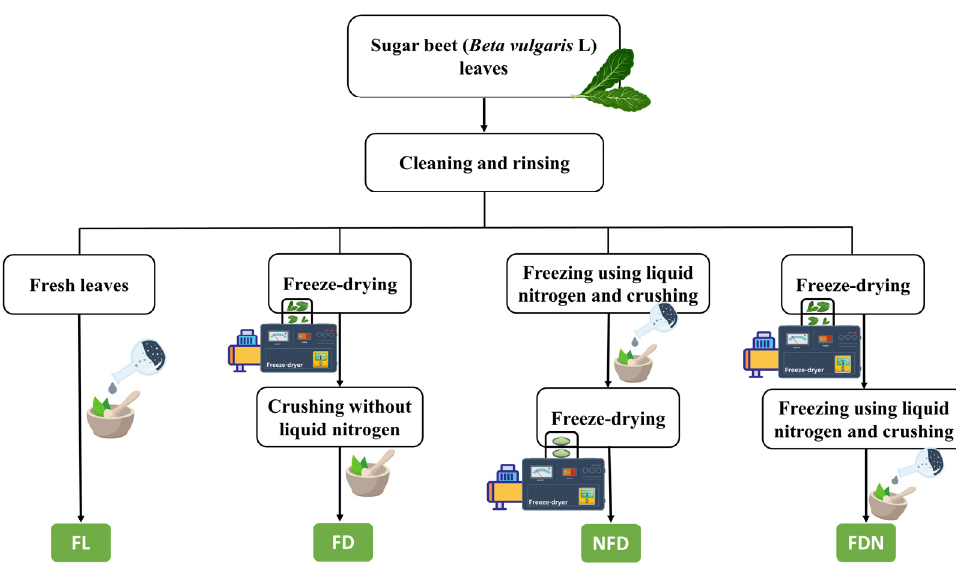
Figure 1. Preparation of samples with four different simple methods. FL: Fresh sugar beet leaves (SBLs); FD: Lyophilized SBLs ground without liquid nitrogen (LN); NFD: Lyophilized SBLs ground with LN before freeze ‐ drying; FDN: Lyophilized SBLs ground with LN after freeze ‐ drying.